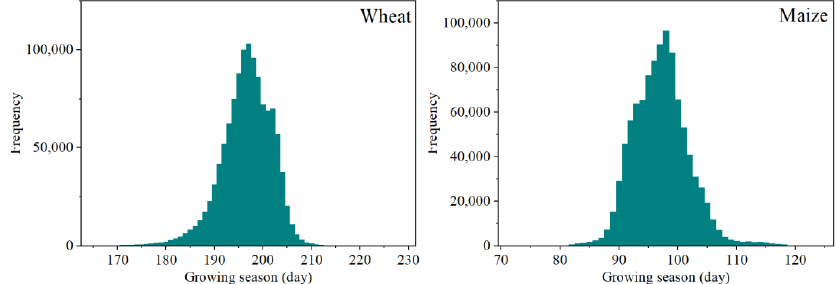
Figure 13. Frequency distribution of crop phenological periods.